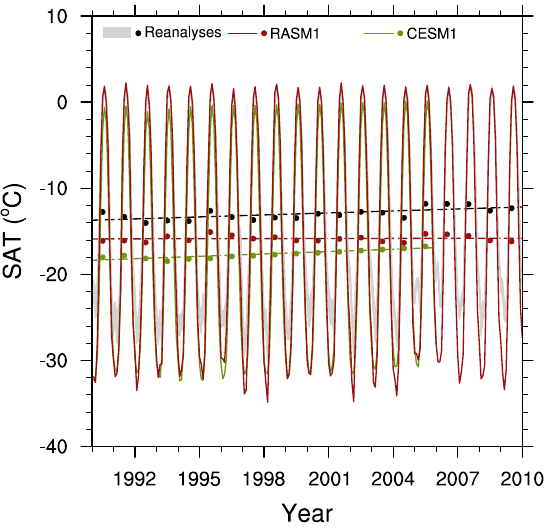
Figure 16. Monthly (lines and shading) and annual (dots) mean 2m surface air temperature (SAT) over the central Arctic (70 ◦ N and poleward) in RASM1 (red), CESM (green), and the reanalyses (spread as gray shading and the annual mean as black dots). The linear regressed trends in the annual SAT are shown as the dashed